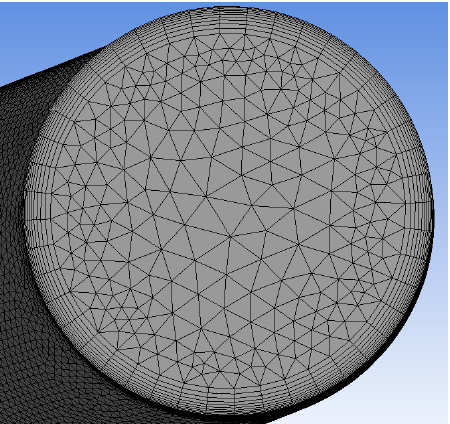
Figure 17. Mesh of fluid zone. Notice the refined mesh near the boundary.